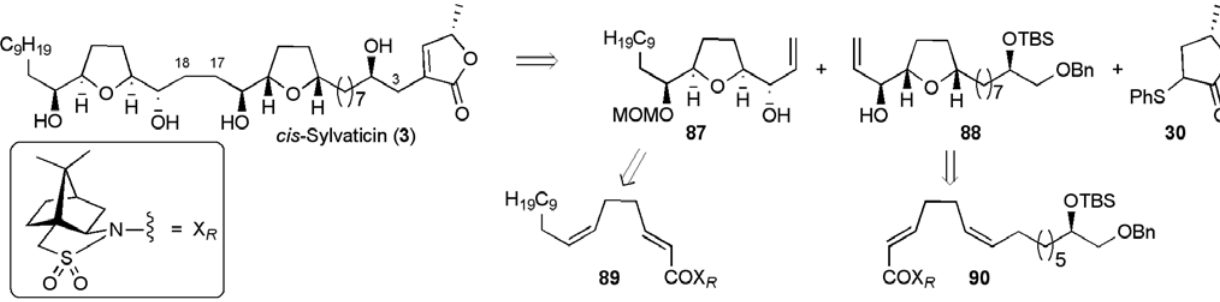
Figure 13. Permanganate-mediated approach to cis -sylvaticin ( 3 ).